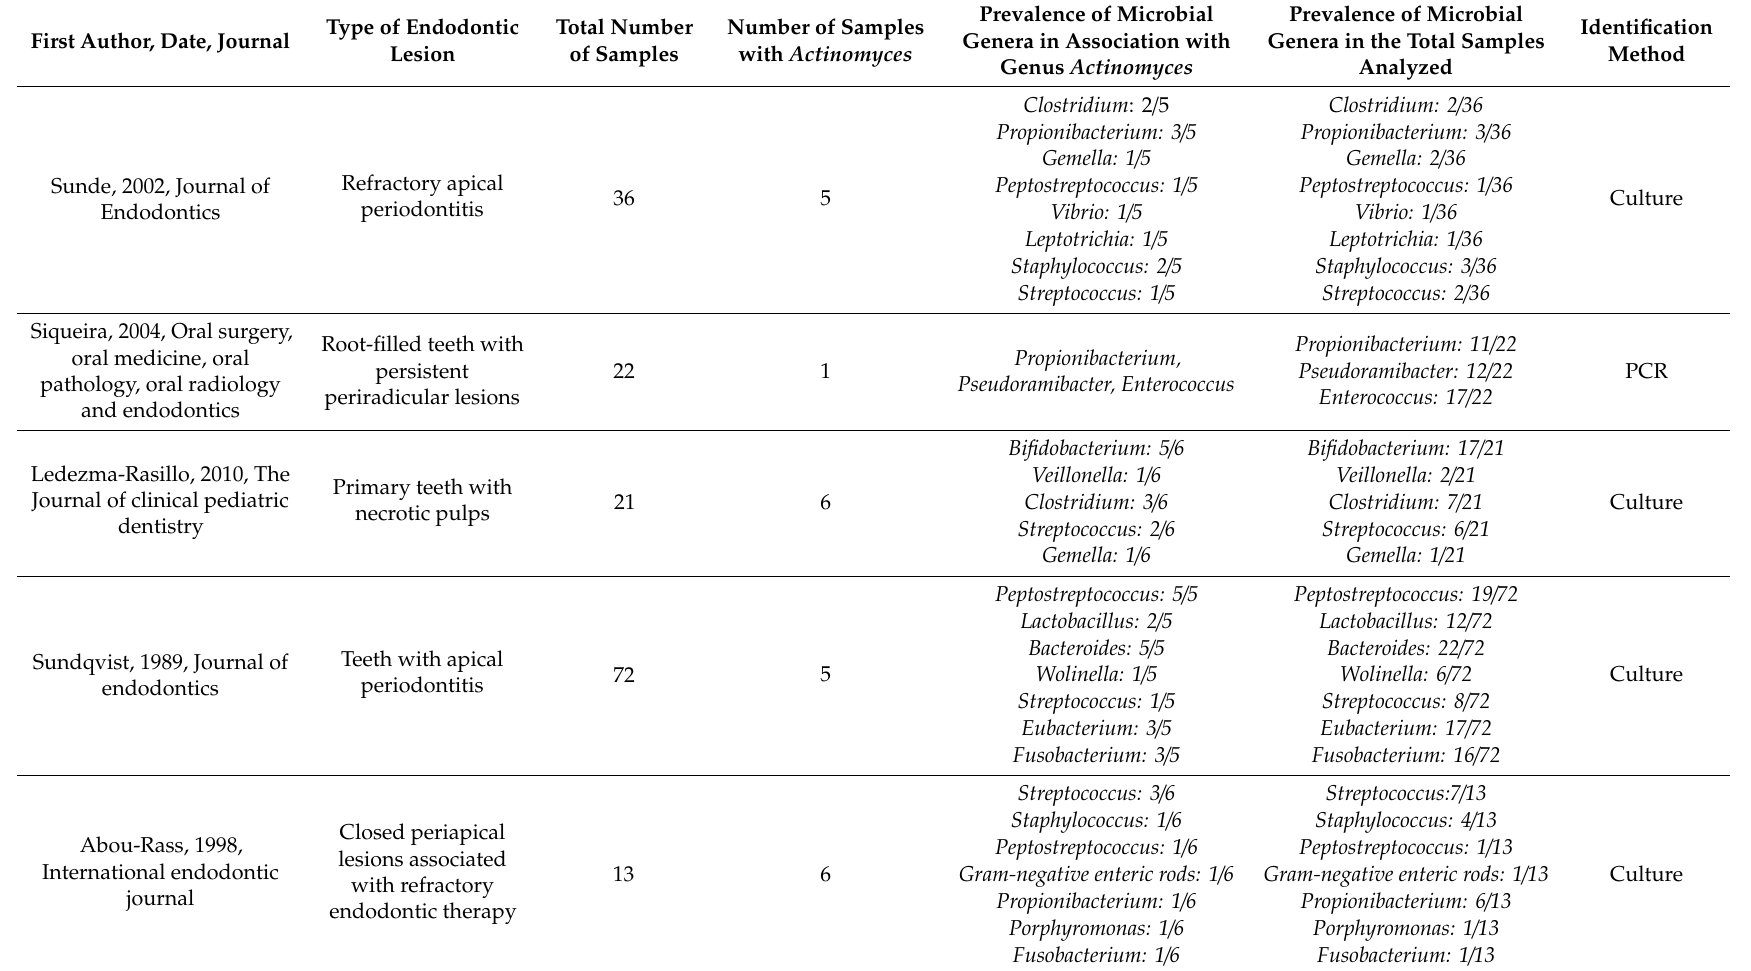
Table 2. Primary outcome: prevalence of microbial genera in the samples in association with bacteria of the genus Actinomyces , and their prevalence in the total samples analyzed in each